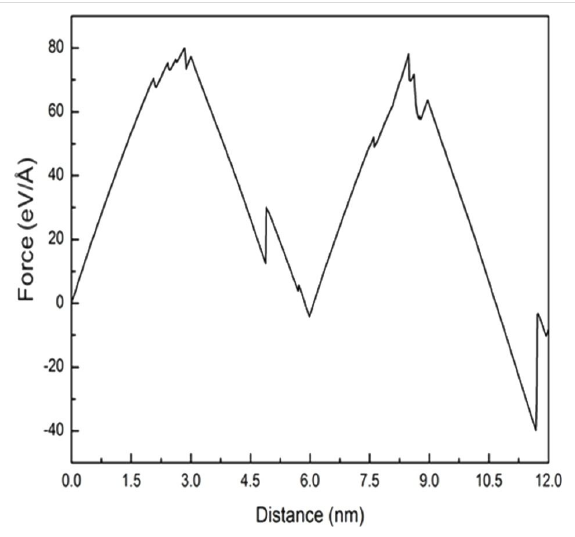
Figure 2: Force–distance curve of Ni under two times of cyclic loading, where the tension and compression distances of the sample are 3 nm.